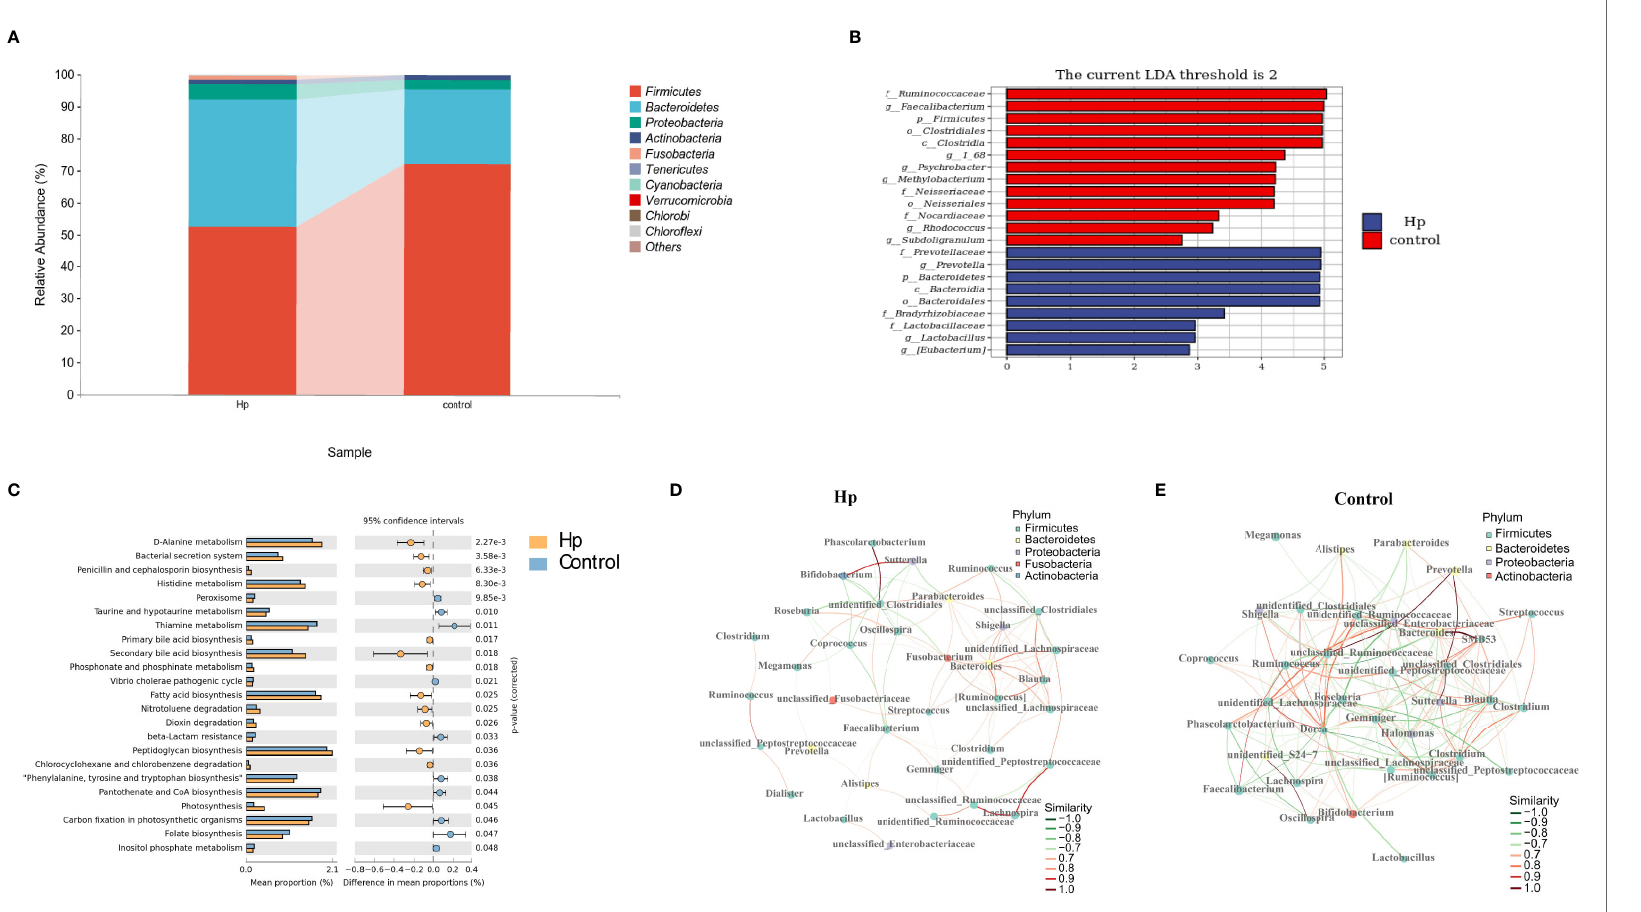
FIGURE 2 | The composition and predicted functional differences between H. pylori -positive patients and normal controls. (A) The composition of the gut microbiota between H. pylori -positive patients and normal controls at the phylum level (the abundance of the top 10 is shown). (B) Differences in speci fi c bacterial taxa between H. pylori -positive and normal controls by LEfSe. (C) Signi fi cant signaling pathways associated with H.pylori infection according to KEGG pathway analysis. Ecological co-occurrence network between H. pylori -positive (D) , and normal controls (E) Hp: H.pylori -positive; Control: H. pylori